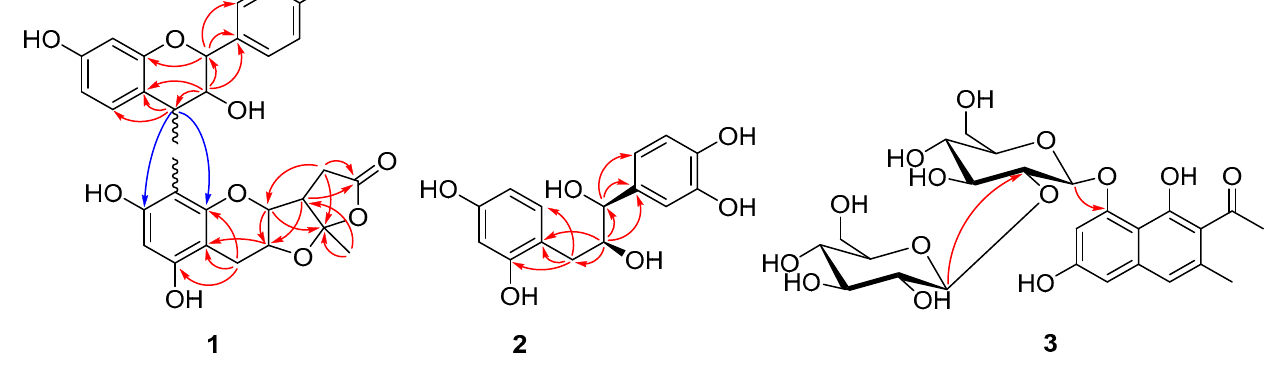
Figure 2. The key HMBC correlations of 1 – 3 .